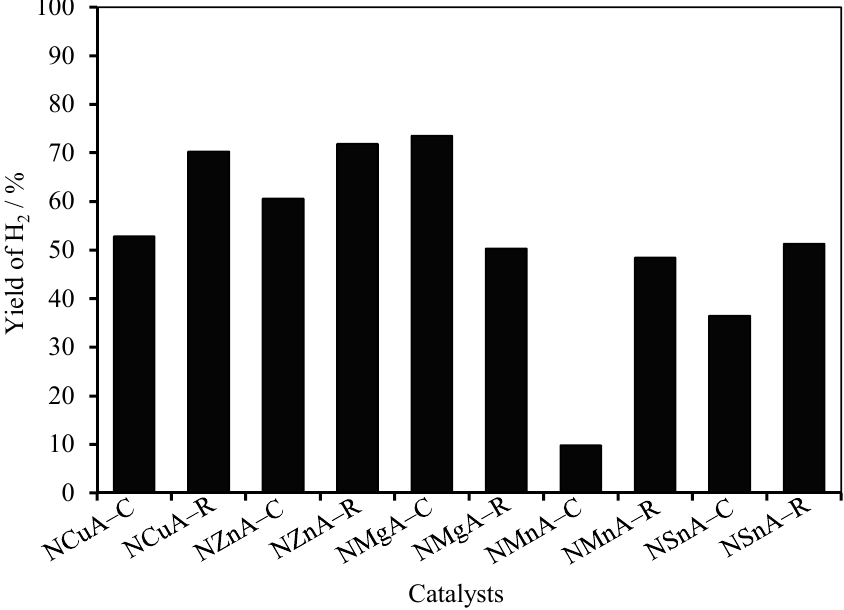
Figure 6. H 2 yield for ethylene glycol APR over hydrotalcite-derived catalysts.